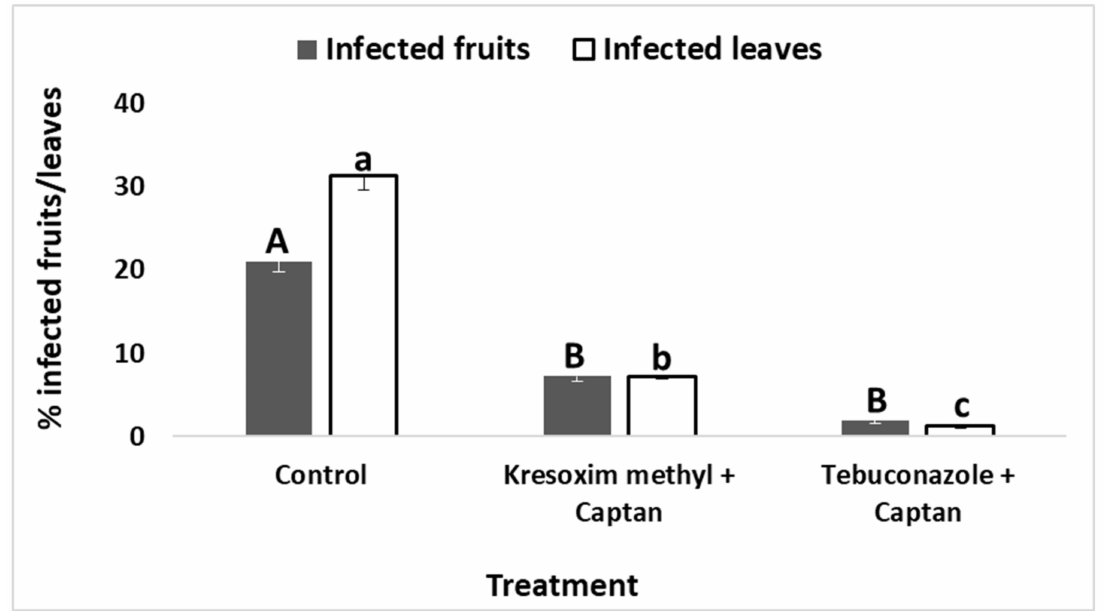
Figure 3. Activity of strobilurin and triazole fungicides in mixtures with captan on apple scab development in the Majdal Shams orchard 2010. The tank mixture of kresoxim-methyl at 0.015% (w/v) + captan 0.25% ( w/v ) and the prepacked mixture Orpan at 0.3% (containing tebuconazole + captan) were tested. Bars represent the standard error of the mean. Different letters on the bars indicate significant differences ( p < 0.05) according to Fisher’s LSD K-ratio t -test.